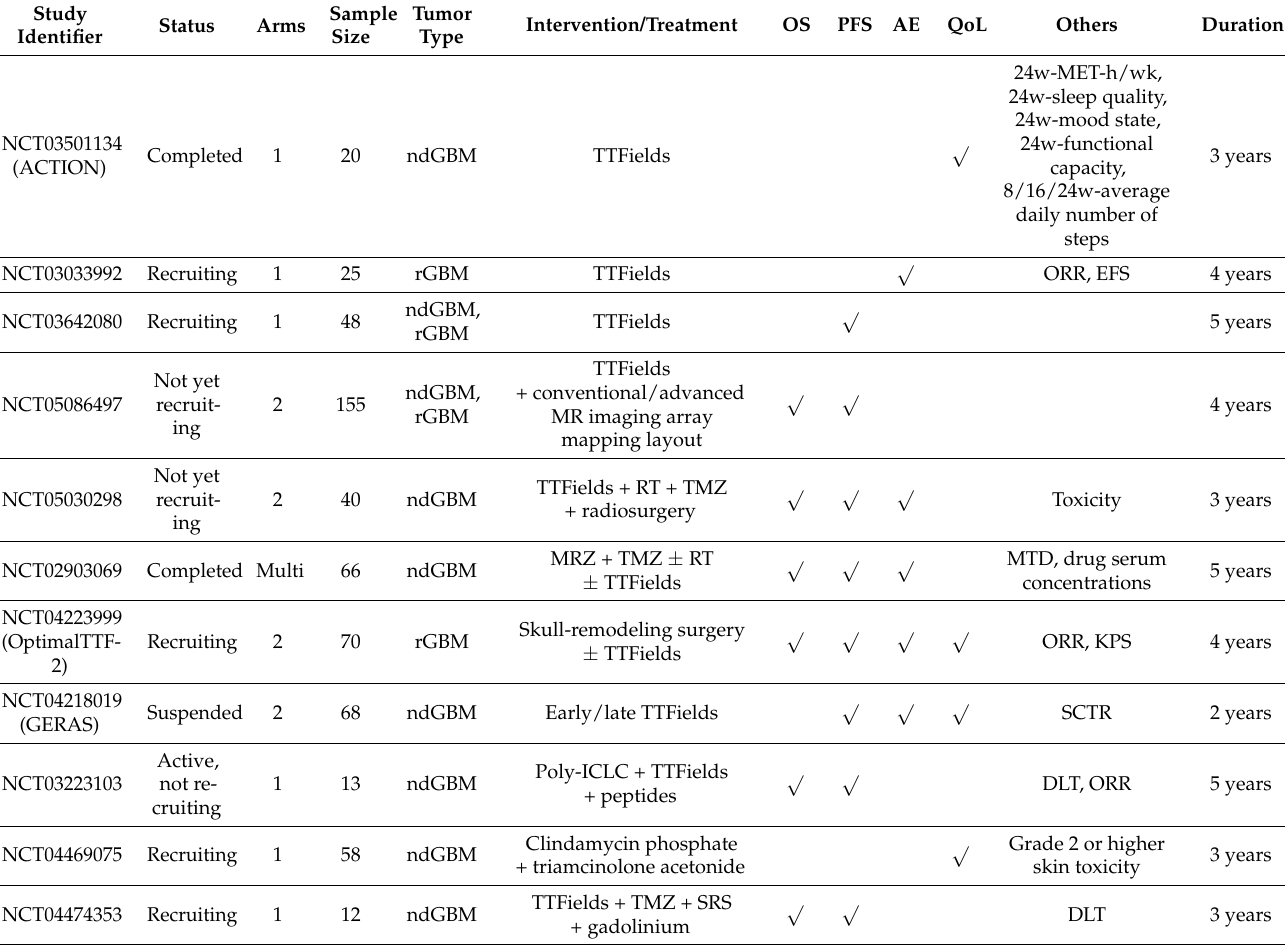
Table 2. Ongoing trials of TTFields in glioblastoma as of 15 May